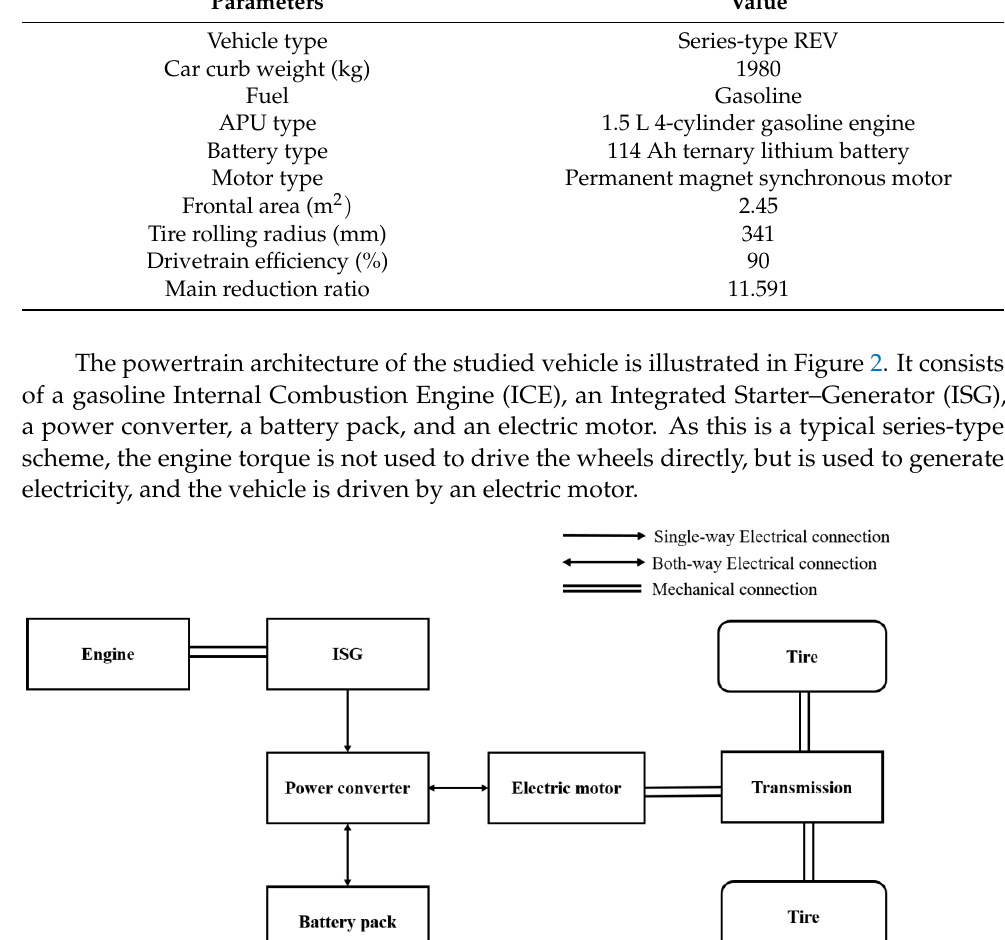
Figure 1. The target vehicle in this study. Table 1. Vehicle specifications. Table 1. Vehicle specifications.